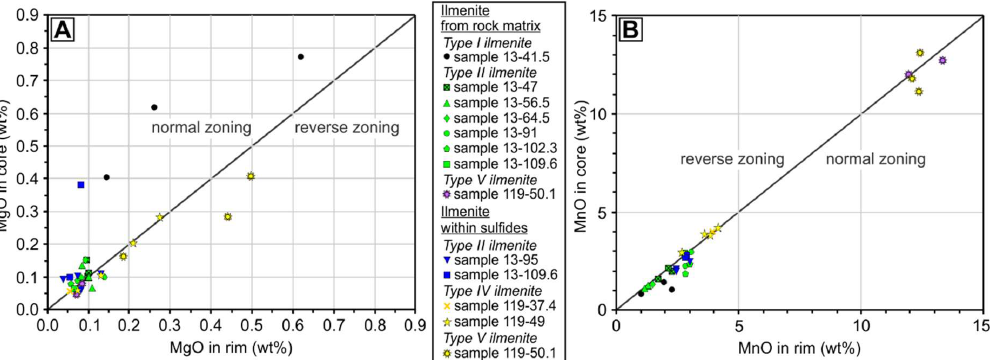
Figure 5. Plots of MnO (wt%)–MgO (wt%) ( A ), Cr 2 O 3 (wt%)–MgO (wt%) ( B ), MgO (wt%)–FeO-rec (wt%) ( C ), and MnO (wt%)–FeO-rec (wt%) ( D ) for ilmenite from the metamorphosed mafic-ultramafic rocks of the Sedova Zaimka intrusion. The FeO-rec values are FeO contents recalculated from FeO total , in accordance with Carmichael [52]. Data from Table S1.